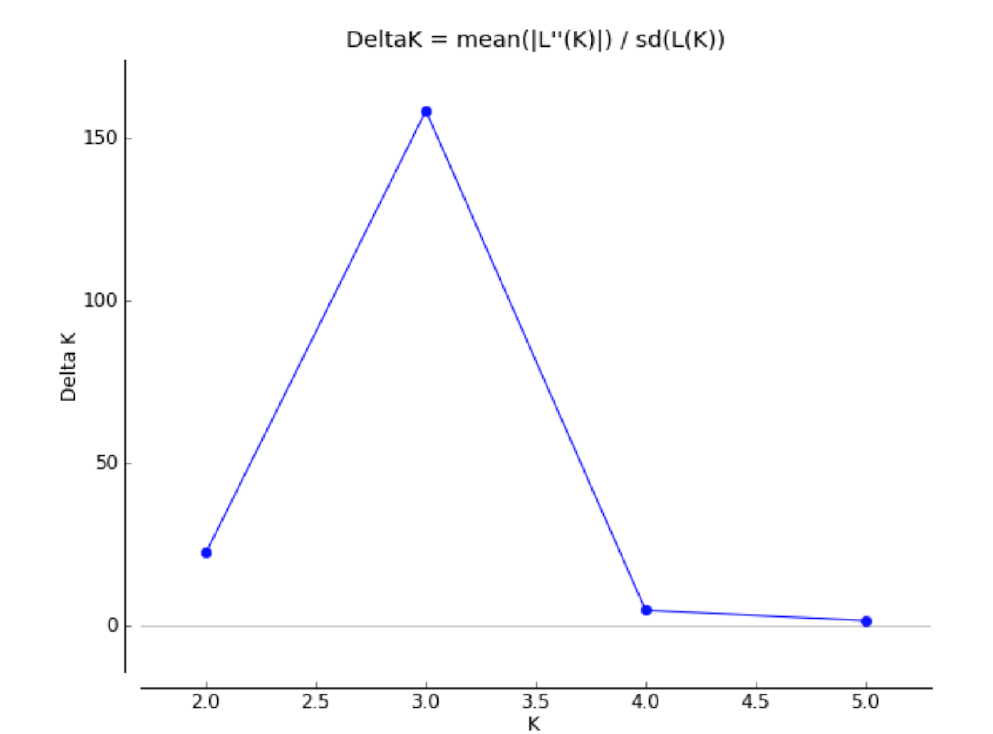
Figure A1.1 Delta K plot identifying the most probable K using the Evanno method as implemented in Structure Harvester for the results of STRUCTURE